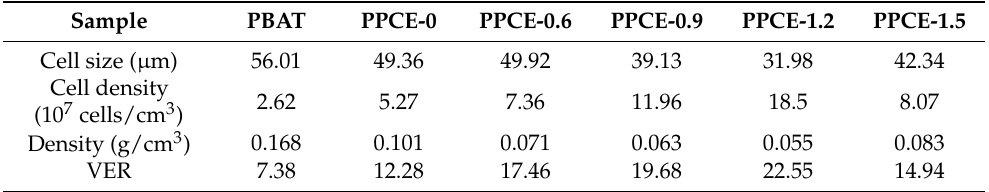
Table 3. Foam parameters of PPCE samples with different degrees of chain extension at a foaming temperature of 120 ◦